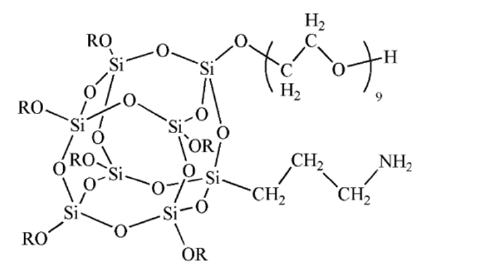
Figure 2. Silica of a cubic structure with an aminopropyl and PEO branches. With an increase of AGM content in the ASiP–AGM composition up to the complete replacement of TEOS by AGM, a shoulder appears and increases in the spectra on the region of 1050 cm − 1 . According to References [46,47], the presence of one broad band in the 1050–1100 cm − 1 region is characteristic of cyclic (a) and framework (b) silsesquioxane structures (Figure